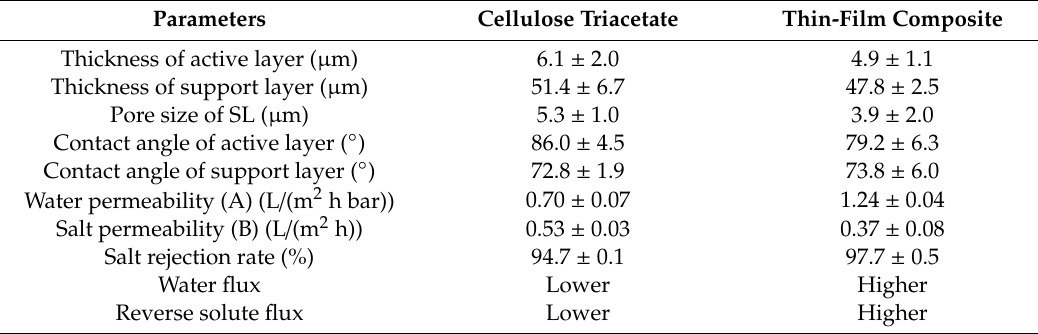
Table 1. Comparison of commercial CTA and TFC membrane produced by Hydration Technologies Innovation (HTI, Albany, NY, USA). Adapted with permission from Wang, Tang, Zhu, Dong, Wang and Wu [30], Copyright (2014), Elsevier